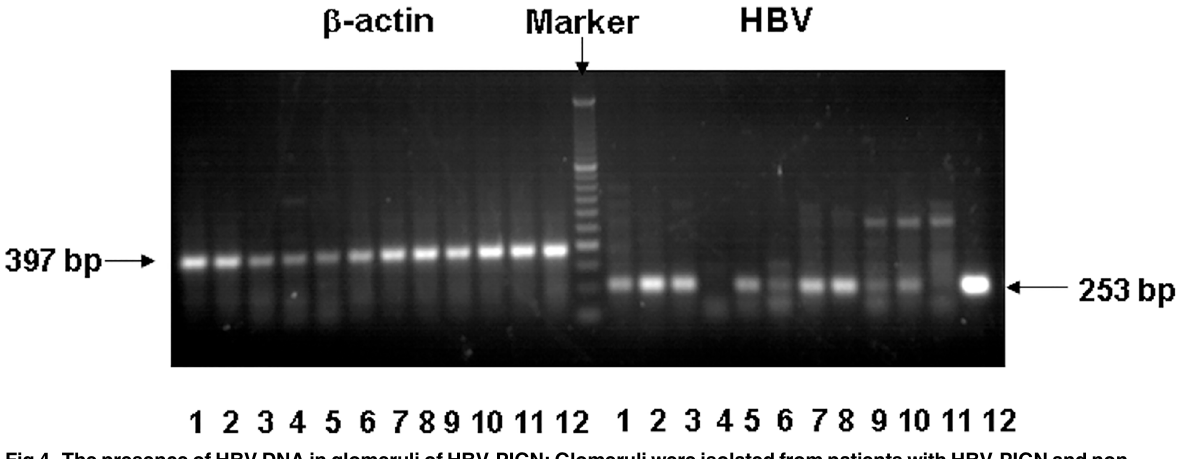
Fig 4. The presence of HBV DNA in glomeruli of HBV-PIGN: Glomeruli were isolated from patients with HBV-PIGN and non- HBV associated PIGN. HBV-DNA in glomeruli were detected by PCR. β -actin was used as a control to verify genomic DNA presence. PCR products with correct size were analyzed by agarose gels together with molecular markers. Representative gel shows the result of HBV-DNA and β -actin PCRs. Lane 1 – 10 were the glomeruli from each of 10 patients with HBV-PIGN. Lane 11 was the glomeruli from a patient with non-HBV associated PIGN. Lane 12 was a sample from HBV DNA infected liver tissue as a positive control. HBV DNA was negative in patient with non-HBV associated PIGN (lane 11) and in one HBV-PIGN patient (lane